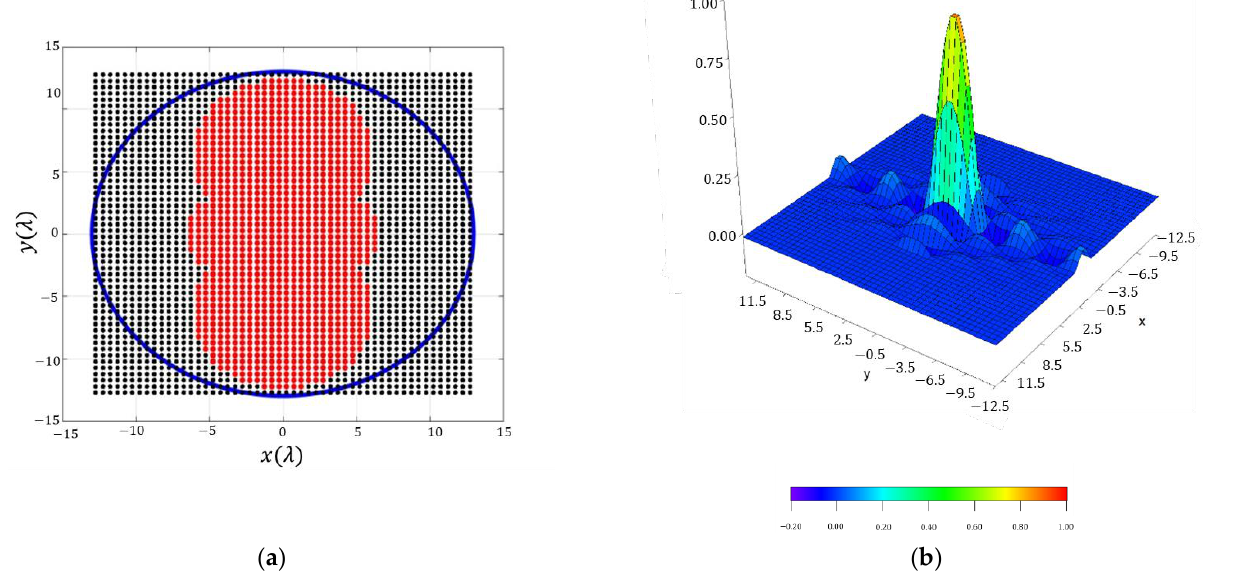
Figure 12. Discretized array antenna which generates the pattern of Figure 11: ( a ) antenna array configuration (the red dots represent the elements switched ON) within a rectangular lattice and for a maximum radius of 12.5 λ. ( b ) Normalized excitation currents of the array antenna.